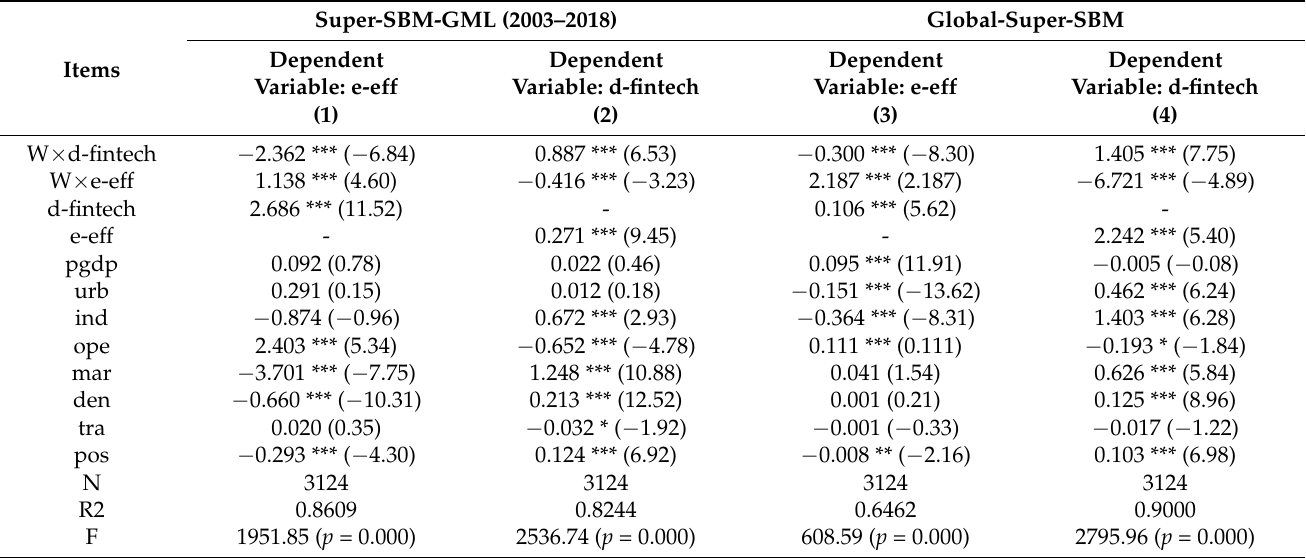
Table 8. Results of robustness test of adjusted